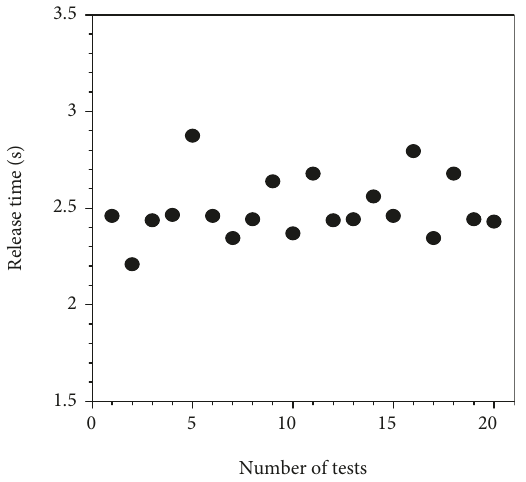
Figure 9: Variation in the release time of a solar panel during 20 times of repetitive release function tests at ambient